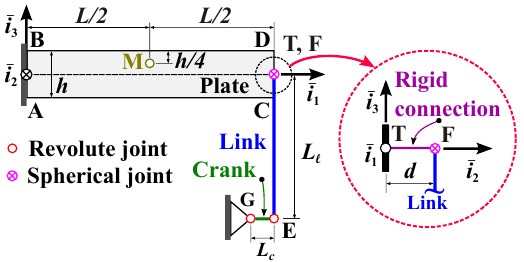
Figure 15. Configuration of the thin